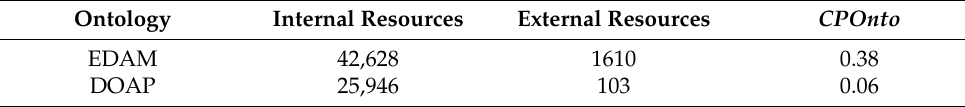
Table 1. Composability metrics for EDAM and DOAP. Ontology Internal